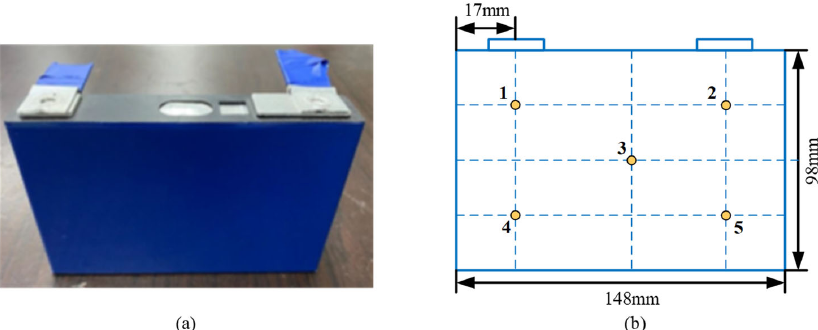
Table 1. Basic parameters of the battery.